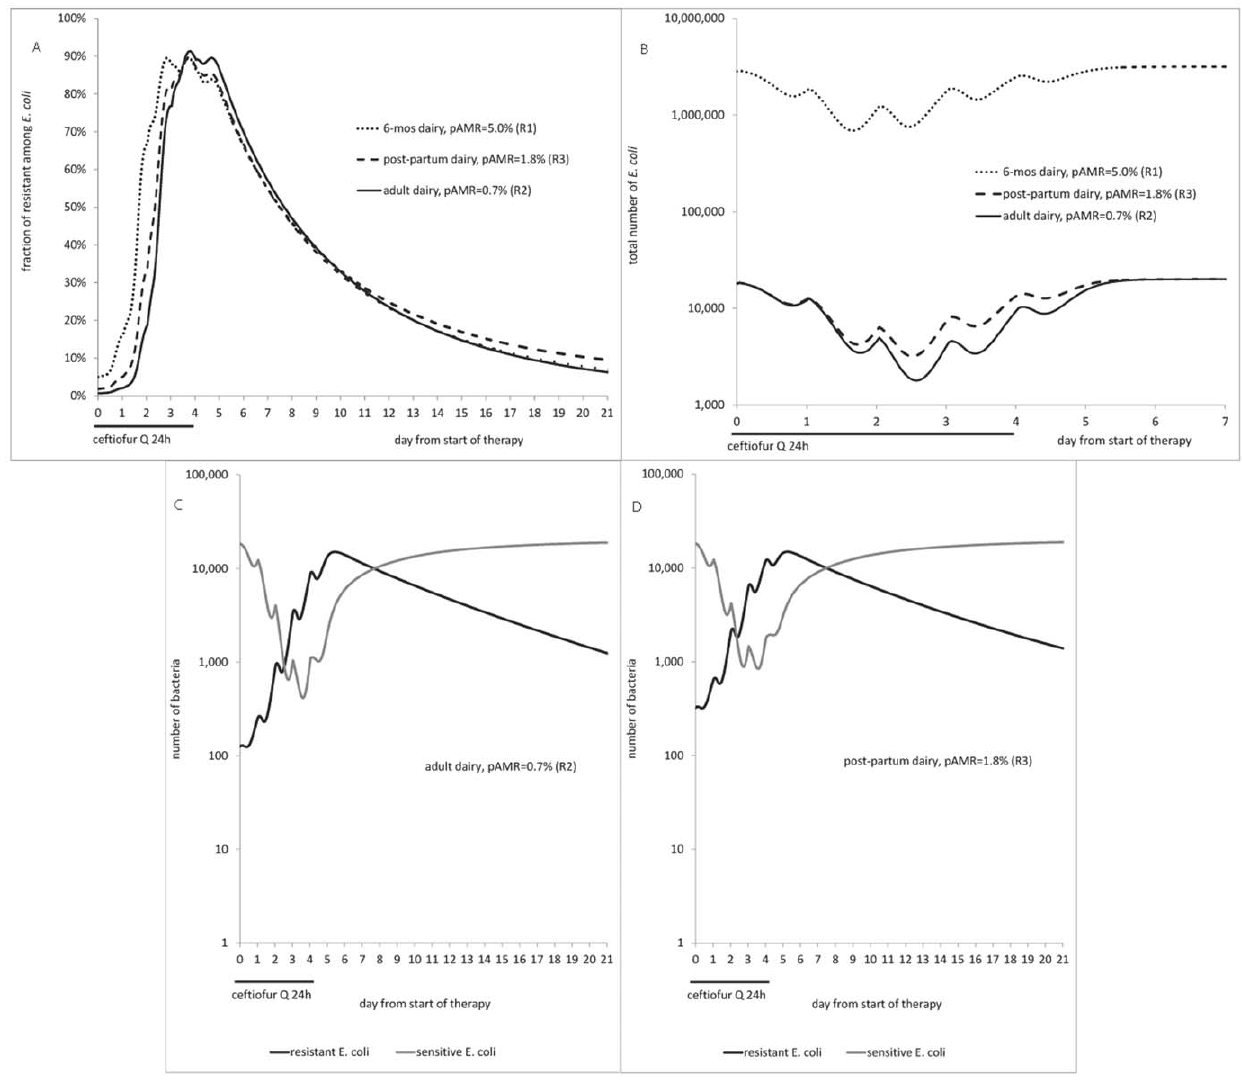
Figure 3. Effect of therapy with repeated ceftiofur administration on enteric E.coli in the deterministic case considered ( r =0.17, a =0.05, b =4 2 3 , c =0.01; all h 2 1 ). A: Fraction of ceftiofur-resistant among E. coli . B: Total number of E. coli . C: Dynamics of ceftiofur-sensitive and resistant E. coli in an adult dairy. D: Dynamics of ceftiofur-sensitive and resistant E. coli in a post-partum dairy. pAMR=frequency of resistance at start of